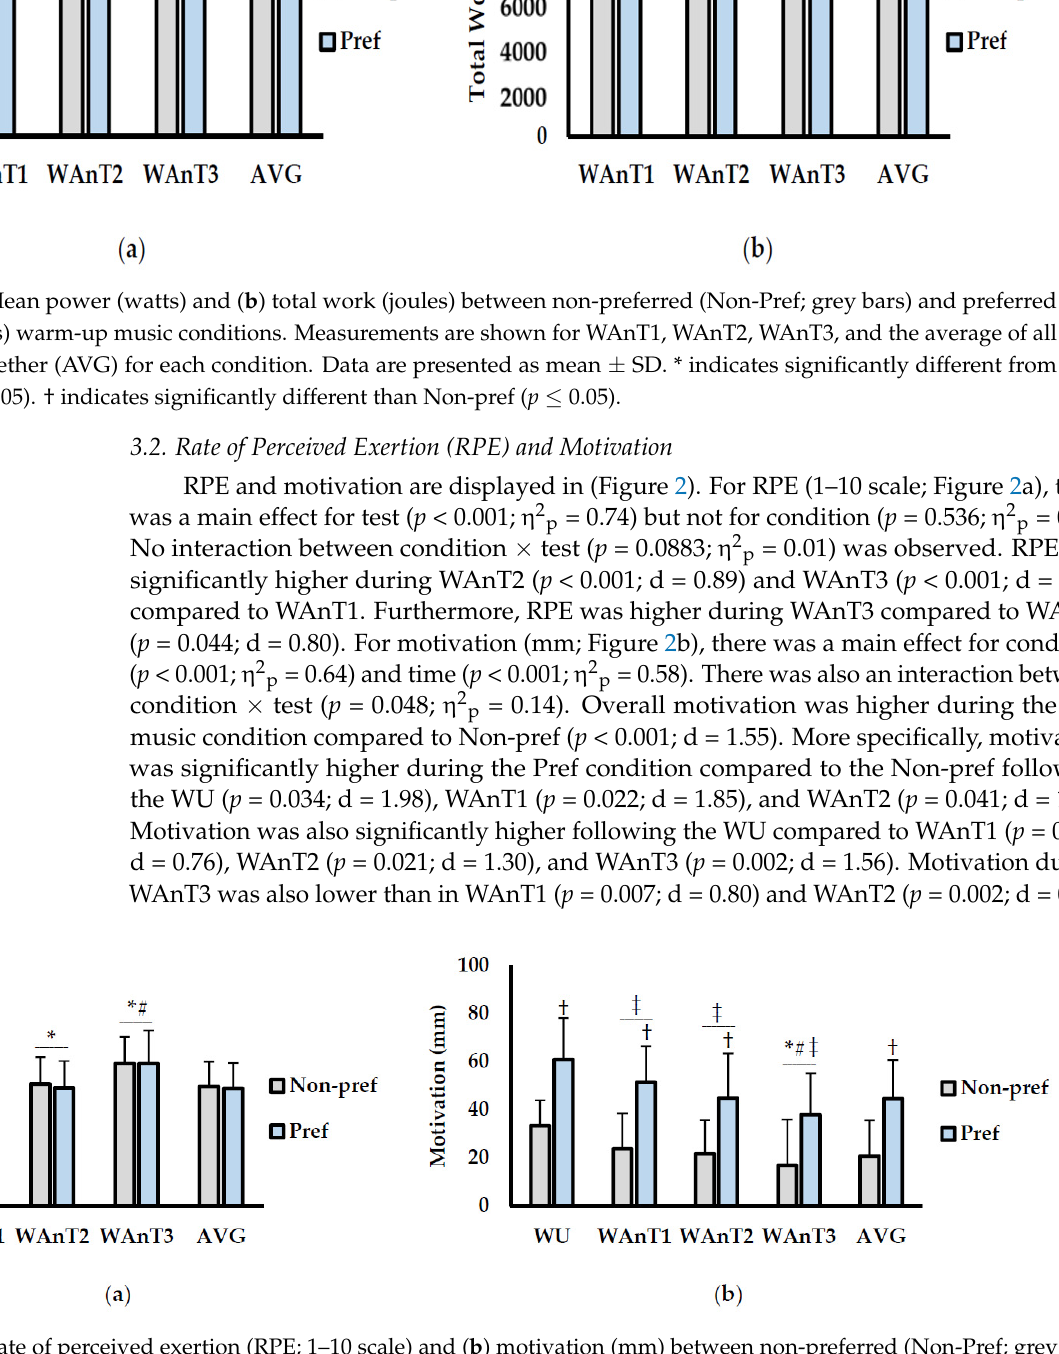
Figure 2. ( a ) Rate of perceived exertion (RPE; 1–10 scale) and ( b ) motivation (mm) between non-preferred (Non-Pref; grey bars) and preferred (Pref; blue bars) warm-up music conditions. Measurements are shown for WAnT1, WAnT2, WAnT3, and the average of all three tests together (AVG) for each condition. Data are presented as mean ± SD. * indicates significantly different from WAnT1 ( p ≤ 0.05). # indicates significantly different from WAnT2 ( p ≤ 0.05). ‡ indicates significant different from warm-up (WU) ( p ≤ 0.05). † indicates signi fi cantly di ff erent than Non-pref ( p ≤ 0.05).